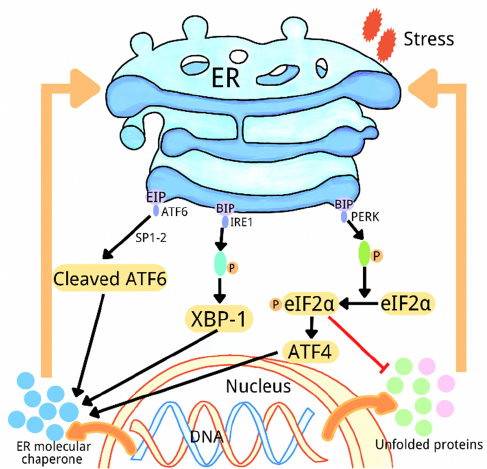
Figure 1. A schematic diagram of three signal pathways of endoplasmic reticulum stress and UPR.